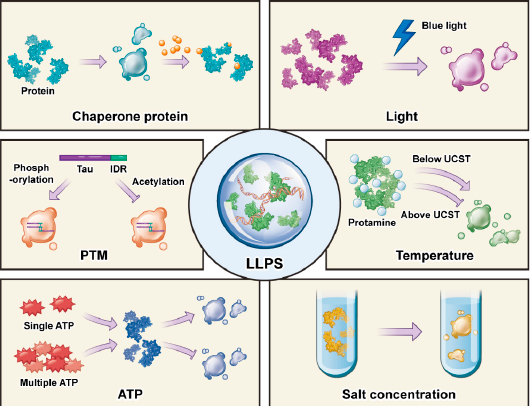
Figure 1. Factors that regulate liquid–liquid phase separation. Several factors, including light, tem- perature, salt concentration, ATP, PTM, and chaperones, can promote/inhibit liquid–liquid separa- tion. Tau is an intrinsically unfolded protein. Abbreviations are as follows: PTM, post-translational modification; IDR, intrinsically disordered region; UCST, upper critical solution temperature.